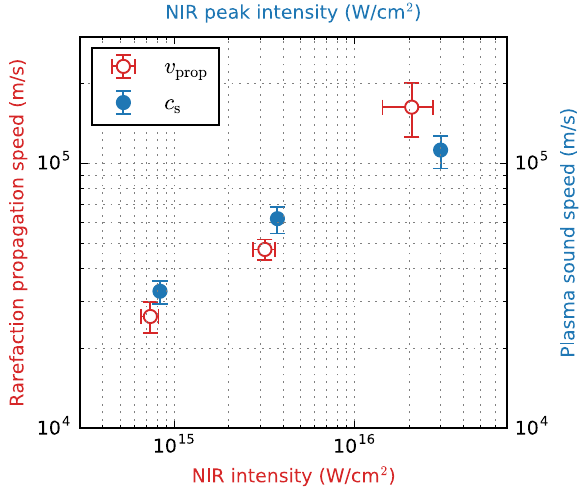
FIG. 4. Red points: propagation speeds v of the crystals prop deduced from the delay dependence of the diffraction intensities plotted against NIR intensity. The NIR intensities are evaluated by considering the spatial intensity profiles (see the main text and Appendix A). The vertical error bars indicate uncertainties originating from the statistical errors in the diffraction intensities. Blue points: plasma sound speeds deduced from the ion TOF spectra of the NIR-irradiated Xe clusters plotted against NIR peak intensity. The vertical error bars indicate uncertainties corre- sponding to the standard deviation of the ion kinetic energies in the fitting